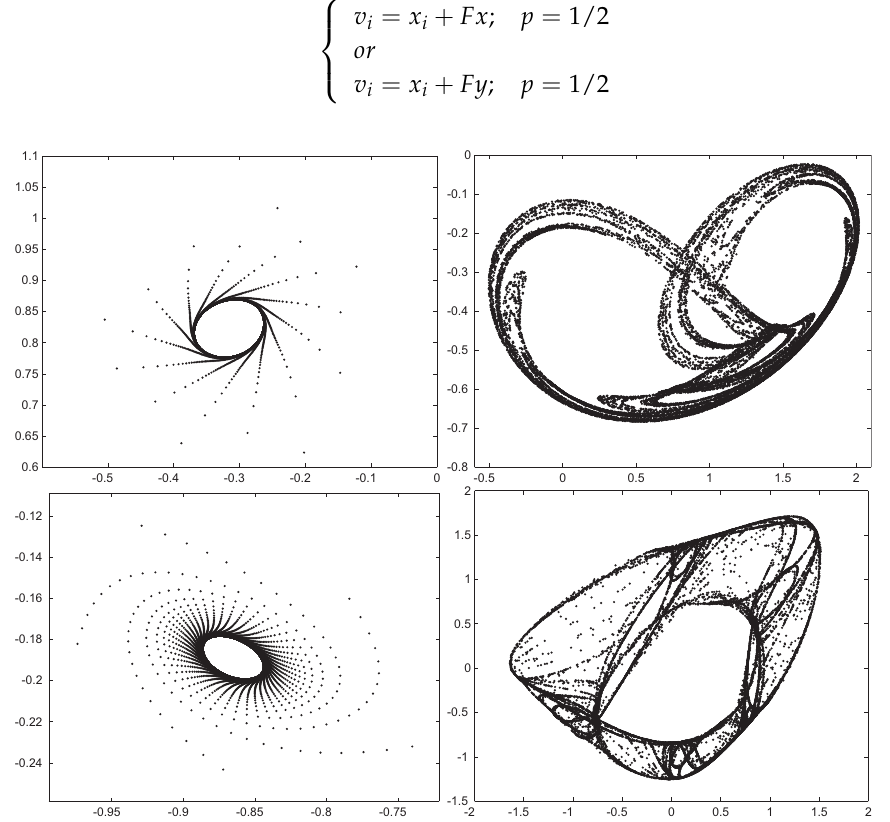
Figure 5. Examples of four strange attractors in the phase space (x vs. y), used in the SA substrate. Each pattern corresponds to a different set of parameters ( a 1 − a 12